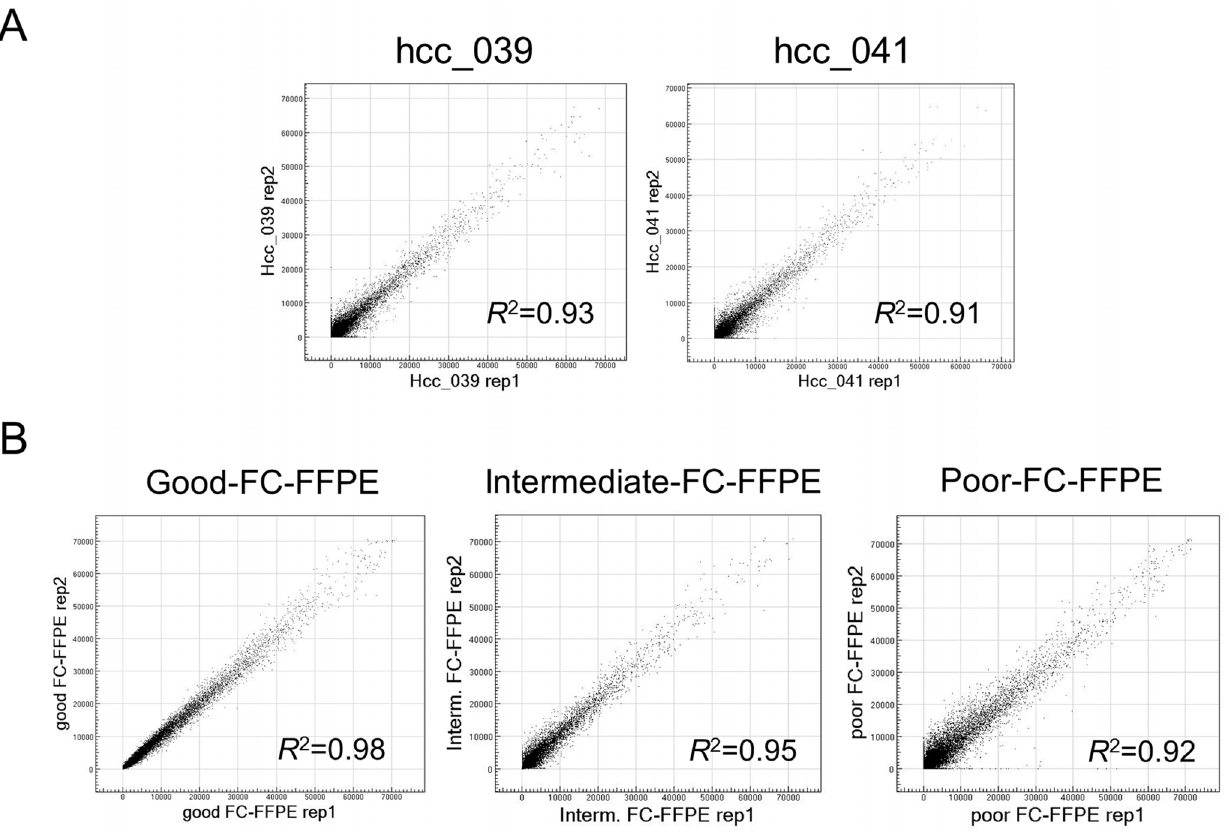
Figure 2. Reproducibility of genome-wide transcriptome profiles in (A) AS-FFPE HCC tissues, and (B) good, intermediate, and poor quality FC-FFPE tissues. Scatter plots of technical replicates are shown for each sample. The AS- and FC-FFPE RNA samples were extracted from different samples. AS: archived section, FFPE: formalin-fixed paraffin-embedded, HCC: hepatocellular carcinoma, FC: freshly cut.